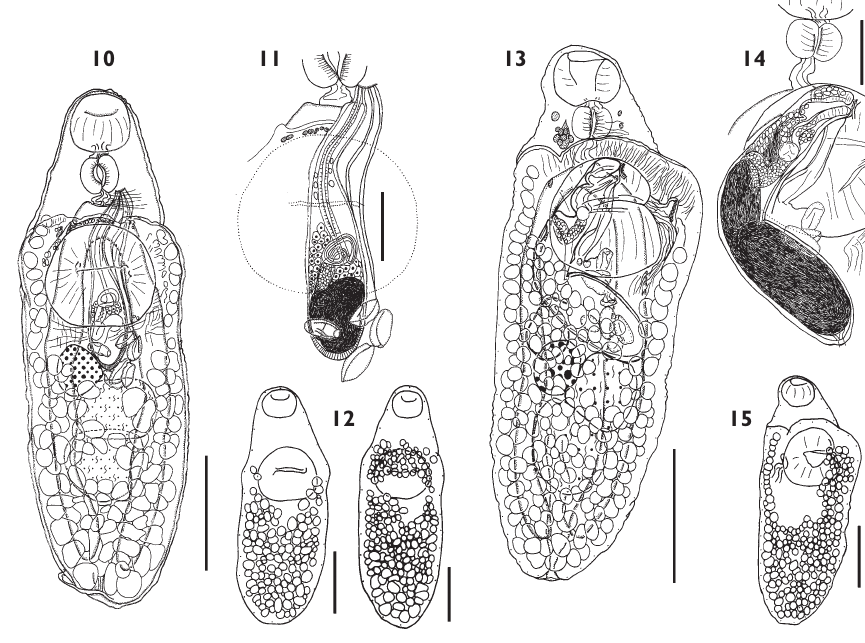
Figs 13-15. Macvicaria mutovitellina n. sp. ex Dactylophora nigricans . 13. Whole-mount ventral view. 14. Terminal genitalia. 15. Dorsal distribu- tion of vitelline follicles. Scale bars : 13, 15, 250 μm; 14, 100 μm.